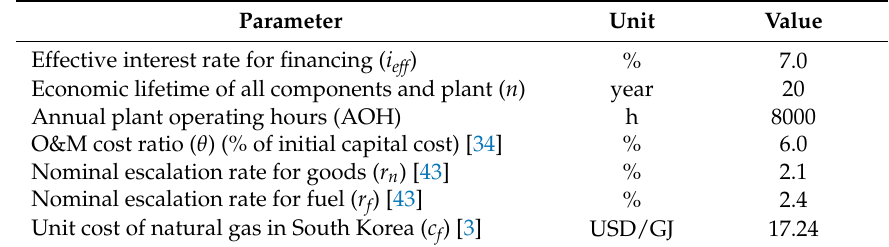
Table 4. Primary assumptions and values used in cost calculations. O&M—operation and maintenance; USD—United States dollar.